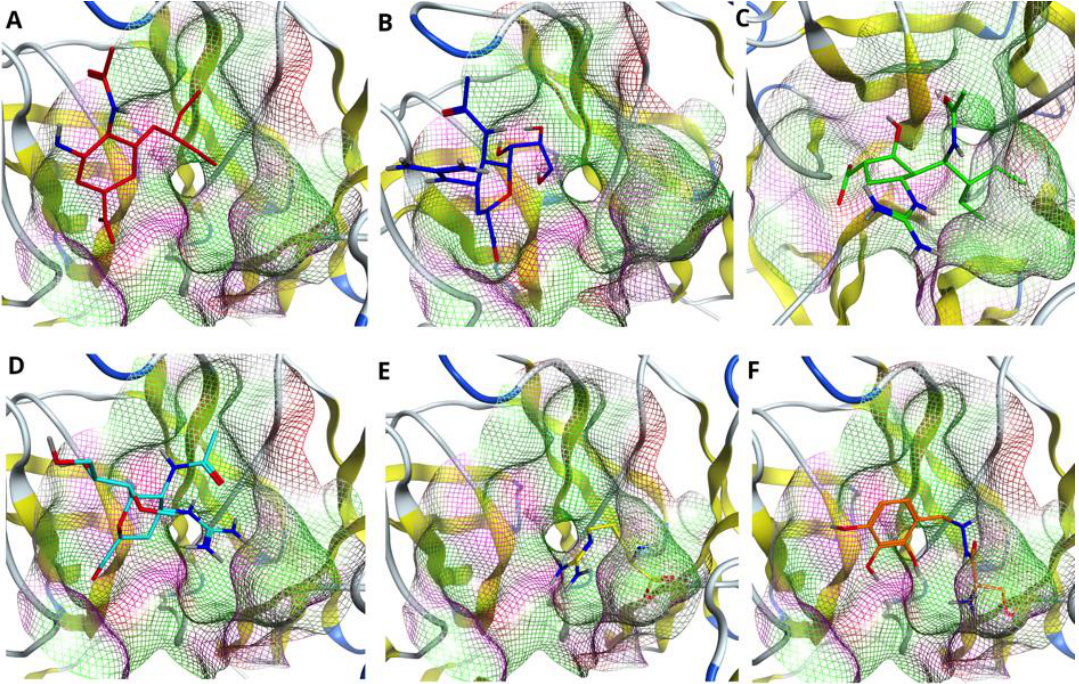
Figure 5. Comparing drug fit to double mutated NA binding pocket. Accommodation of the drugs ( A ) Oseltamivir (red), ( B ) Zanamivir (blue), ( C ) Peramivir (green), ( D ) Laninamivir (cyan), ( E ) L- Arginine (yellow) and ( F ) Benserazide hydrochloride (orange) in the pocket of H7N9 neuraminidase with double R294_119K mutation.